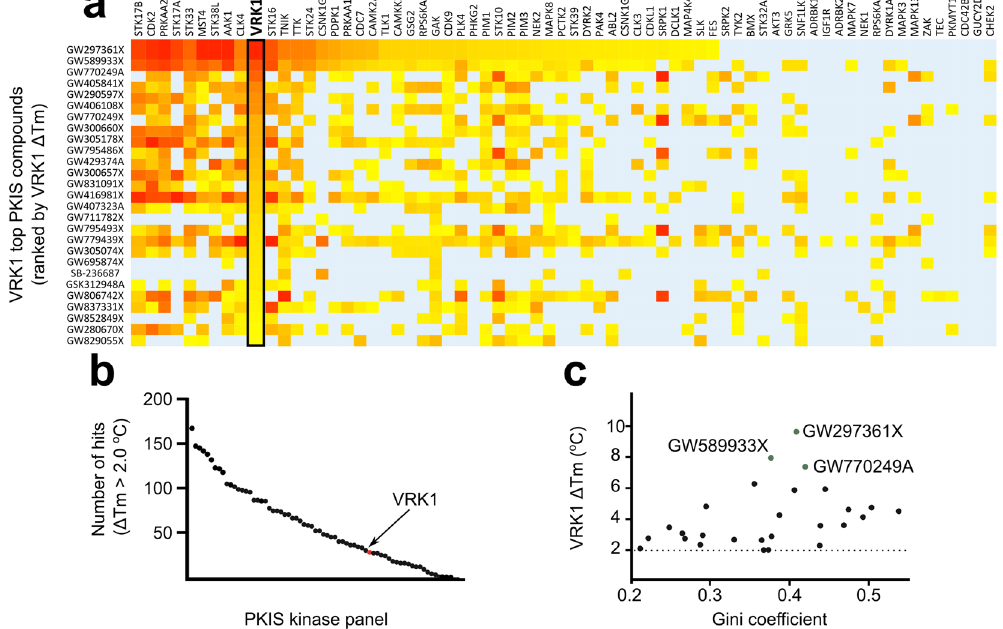
Figure 1. Analysis of published thermal shift assay (DSF) screening data for VRK1-PKIS. ( a ) Heat map showing DSF screening data for PKIS compounds with Δ Tm > 2.0 °C for VRK1 (black box) together with the results for other 67 kinases (x-axis). Compounds were ranked (top to bottom) according to decreasing Δ Tm for VRK1. Background color indicates Δ Tm as a gradient from 2.0 °C (yellow) to the maximum observed Δ Tm for each protein (red). Light blue background color indicates Δ Tm < 2.0 °C. ( b ) Graphic showing number of PKIS compounds with Δ Tm > 2.0 °C (y-axis) for VRK1 (red circle) and other 67 tested kinases (x-axis, black circles). ( c ) Graphic showing the poor relationship between Δ Tm and Gini (selectivity) coefficients for PKIS compounds interacting with VRK1. The top 3 VRK1 hits are